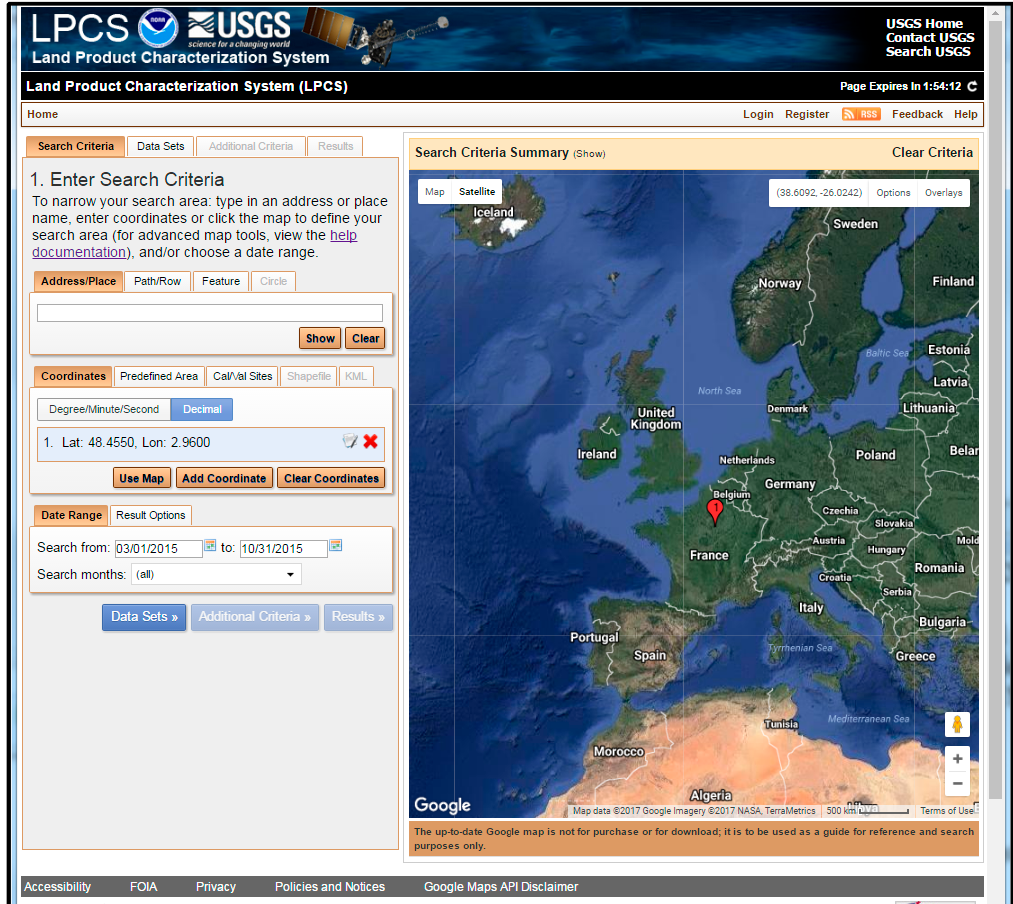
Figure 2. Screenshot of the Search Criteria page.